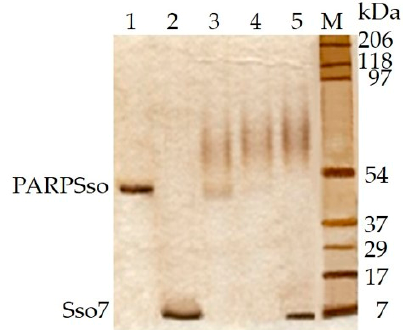
Figure 5. PARPSso and Sso7 interactions. Complexes of the two proteins were evidenced by SDS-PAGE (5–12% gradient) and silver staining of the gel [21]. Lanes: 1, purified PARPSso (3 µ g); 2, purified Sso7 protein (1.2 µ g, 171 pmoles); 3–5, purified PARPSso (3 µ g, 65 pmoles) in the presence of increasing concentrations of Sso7 (1:0.5, 1:1, 1:3, mol / mol). M, pre-stained molecular weight markers (Bio-Rad), as in Figure